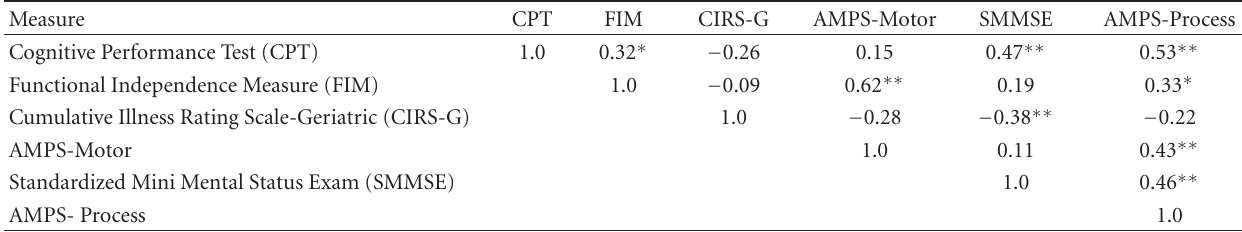
Table 2: Pearson correlation coe ffi cients of CPT with validation measures.